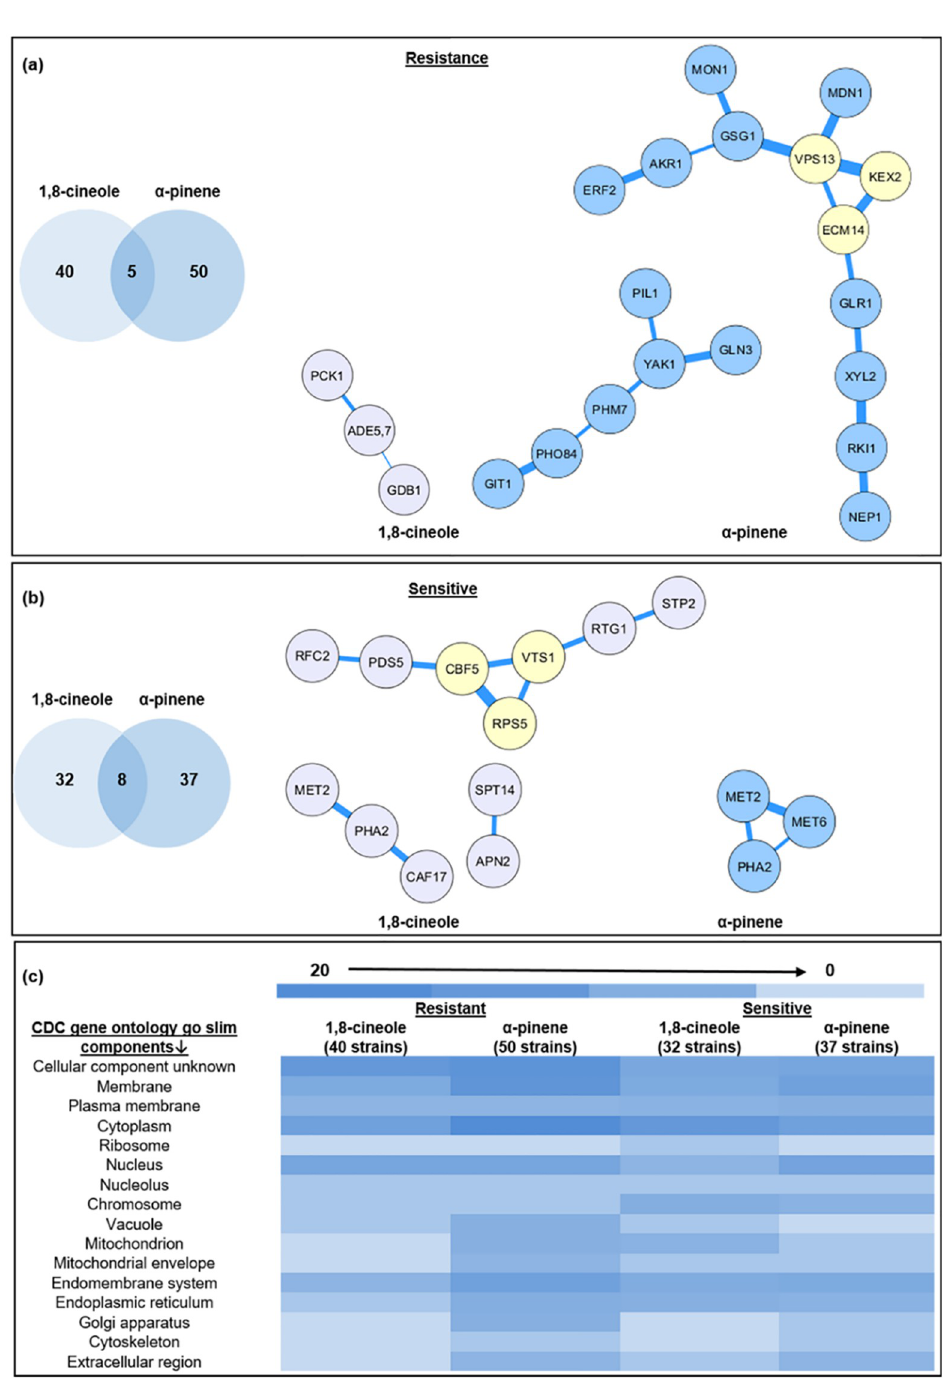
Fig 1. Overview of PPI Network of C . albicans genes for strains resistant and sensitive to EOCs. (a,b) Comparison of genes showing resistance and sensitivity to 1,8-cineole and α -pinene, including protein-protein interaction networks. (a) There were 5 genes conferring resistance to both 1,8-cineole and α -pinene and (b) 8 conferring sensitivity to both 1,8-cineole and α -pinene. Thick lines represent very high confidence, yellow nodes represent highly interconnected subnetworks. (c) Heatmap of gene product localization to cellular